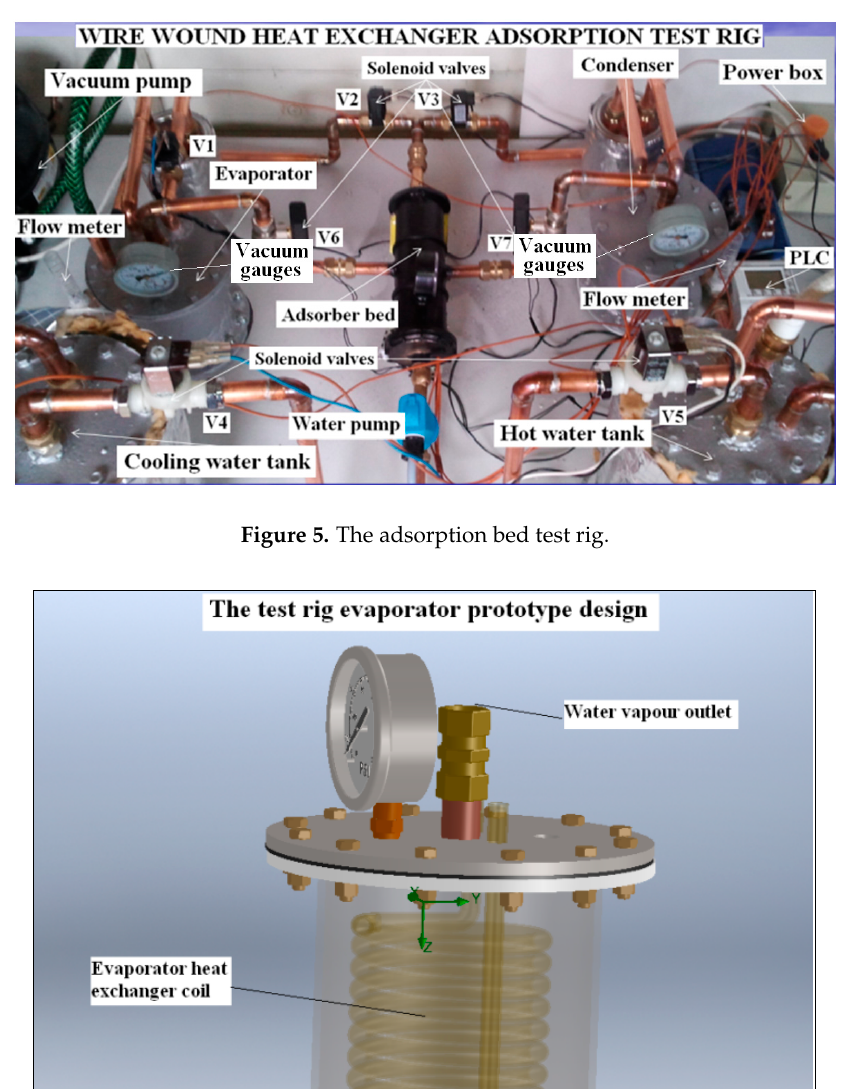
Figure 6. Helix copper coil heat exchanger (designed by J. White ©2012 [10]).